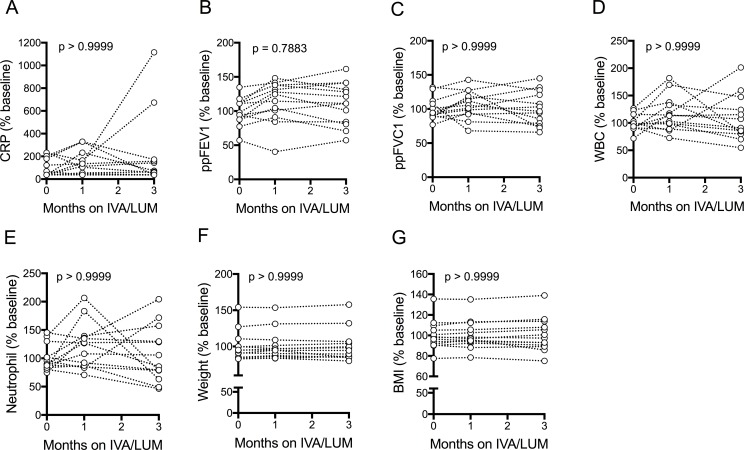
Clinical measurements of patients with CF (homozygous Phe508del) following IVA/LUM treatment.Clinical measurements were taken at baseline, one month and three months from patients homozygous for Phe508del CFTR mutations receiving compassionate use IVA/LUM (n = 13). Measurements were plotted as % baseline. A, CRP; B, ppFEV1; C, ppFVC1; D, WBC; E, Neutrophil; F, Weight; G, BMI. A non-parametric Kruskal-Wallis statistical test with Dunn’s multiple comparison was performed. P value for baseline to three months is shown on each graph.